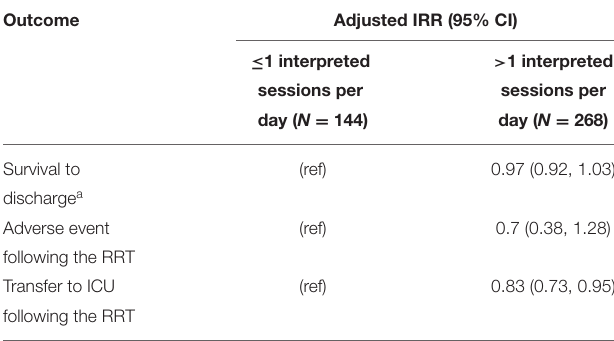
TABLE 5 | Results of adjusted Poisson regression models associating number of interpreted sessions per day (as a binary variable) of hospital stay with each of our measured outcomes during 412 RRTs and 281 hospitalizations from 229 patients who use LOE in the study